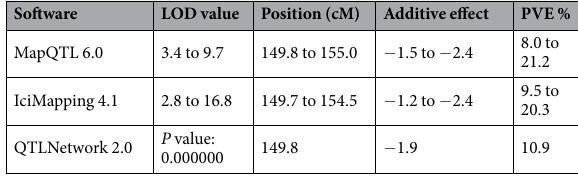
Table 1. qKnps-4A as detected by MapQTL 6.0, IciMapping 4.1, and QTLNetwork